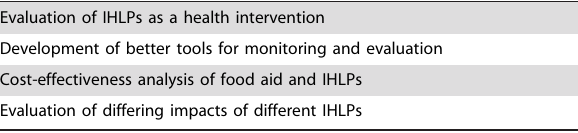
Table 2. Critical areas for further